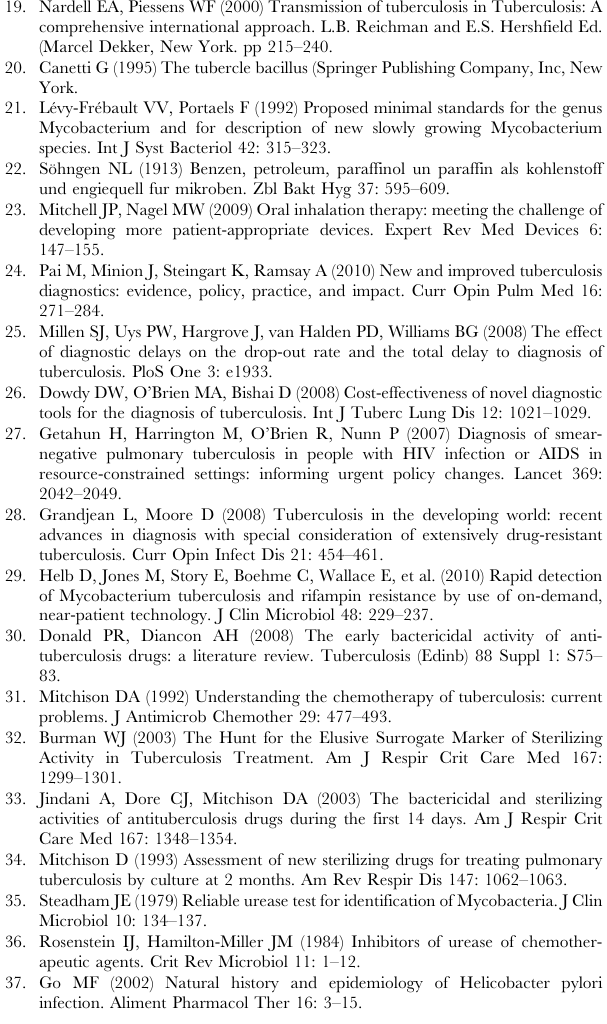
Figure S3 Mean spleen and kidney CFU counts at necropsy. Multiple samples of kidneys and spleens were removed from tissues with the greatest discernable gross pathology. The log CFU count/gram of tissue was determined after tissue homogenization and plating dilutions. Additional information is in Table S1. As noted in previous published experiments, M. tuberculosis H37Rv demonstrated no evidence of extrapulmonary dissemination as compared to M. bovis 24 . Found at: doi:10.1371/journal.pone.0012451.s004 (0.05 MB